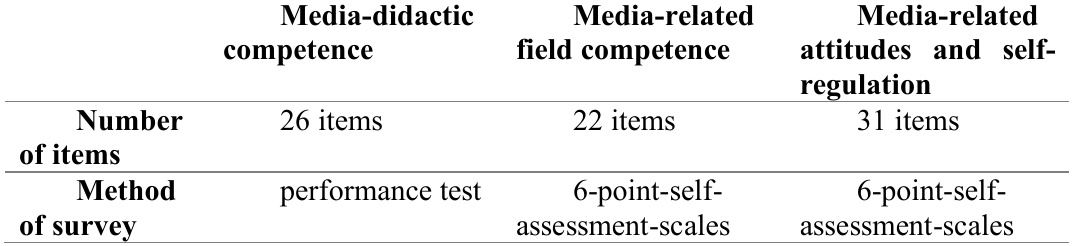
Table 1: content blocks of the test